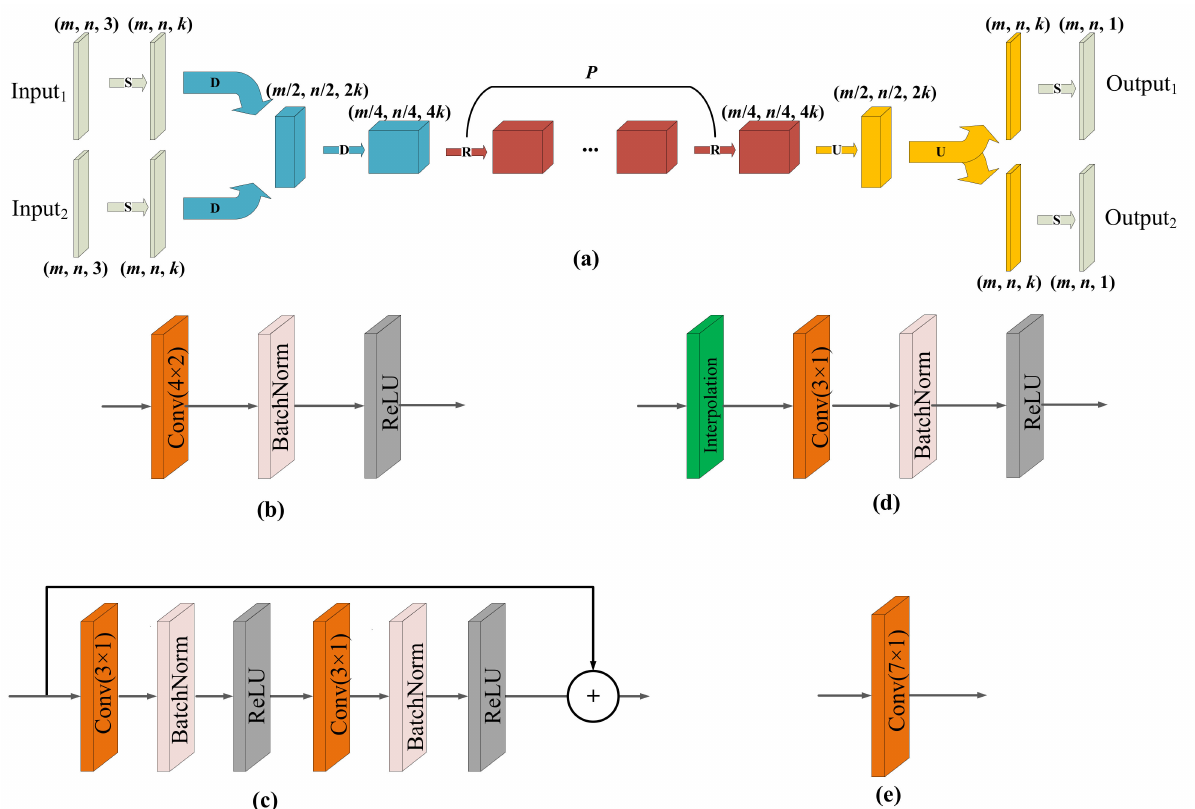
Figure 3. Network structure and specific components of each module. ( a ) is the overall structure of the network, consisting of ( b ) the downsampling module (D-part), ( c ) the residual module (R-part), ( d ) the upsampling module (U-part) and ( e ) the convolution layer at the input and output layers. The data dimensions in each module are expressed as (height, width, channel). A pair of numbers in the convolution layer, e.g., Conv (7, 1) indicates the size and step of the convolution